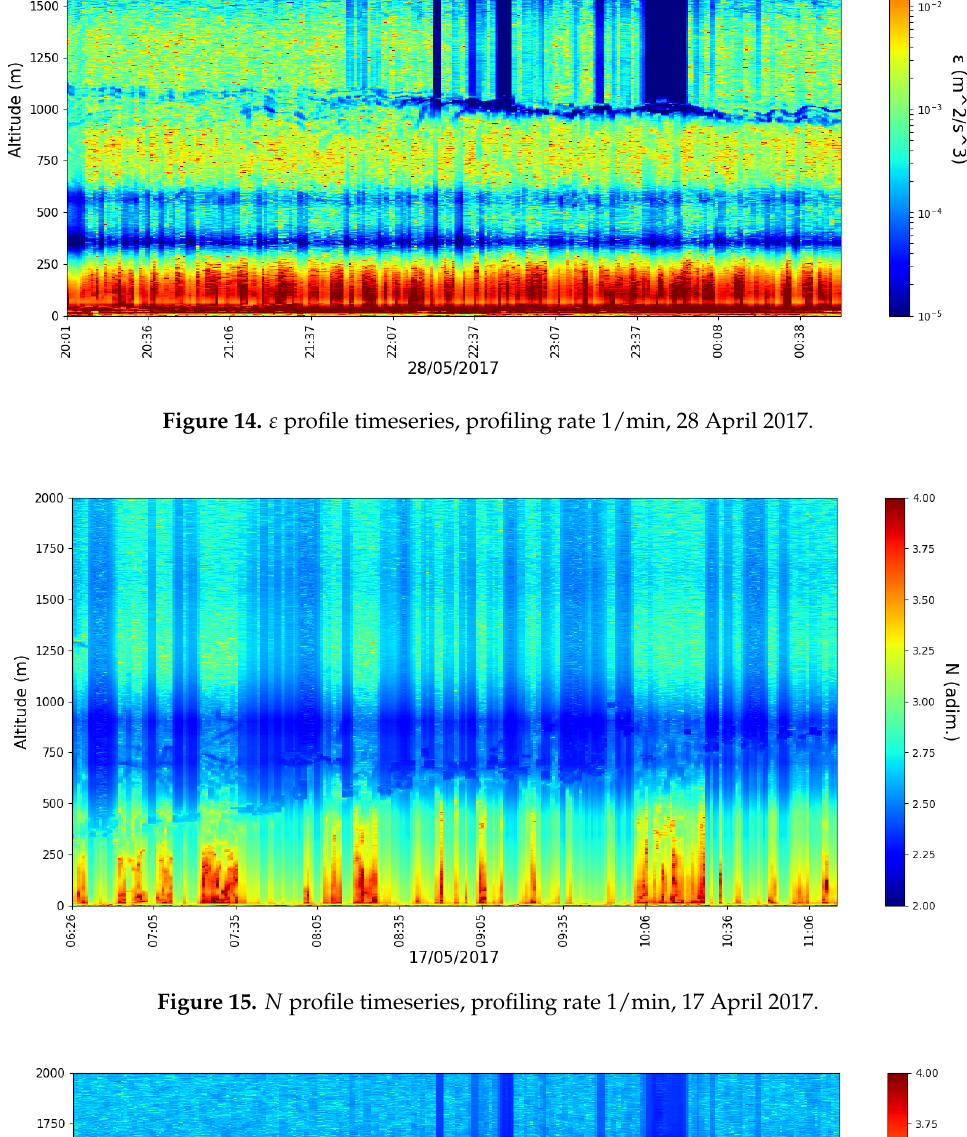
Figure 13. 𝜀 profile timeseries, profiling rate 1/min, 17 April 2017.